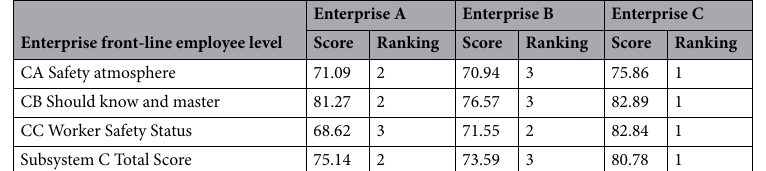
Enterprise front-line employee level